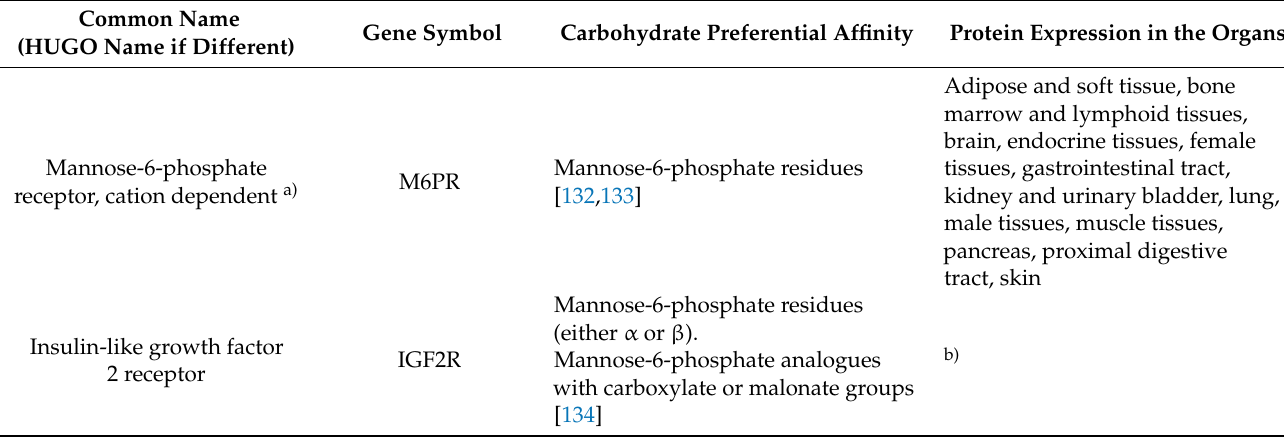
Table 9. Human P-type lectins, their carbohydrate ligands and protein expression in the